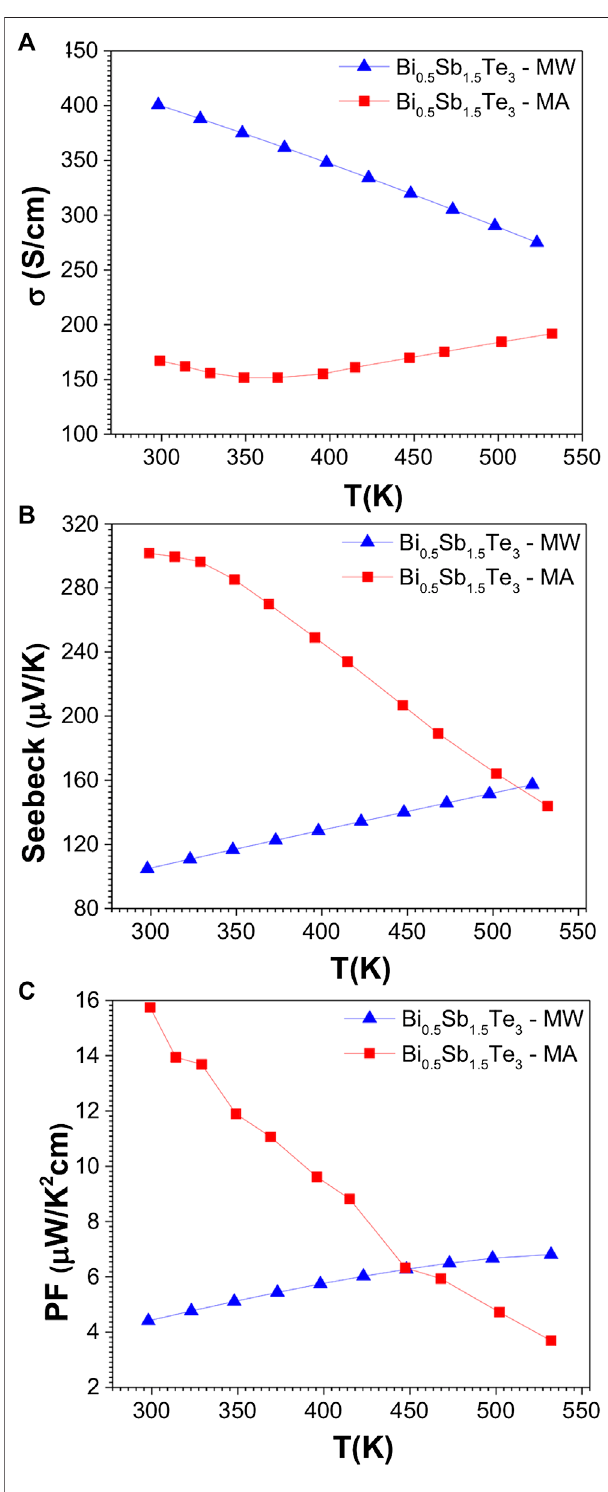
FIGURE 5 | Temperature-dependent electronic transport properties of SP sintered MW-Bi 0.5 Sb 1.5 Te 3 and MA-Bi 0.5 Sb 1.5 Te 3 samples: (A) electrical conductivity ( σ ), (B) Seebeck coef fi cient ( S ), and (C) power factor ( PF ).